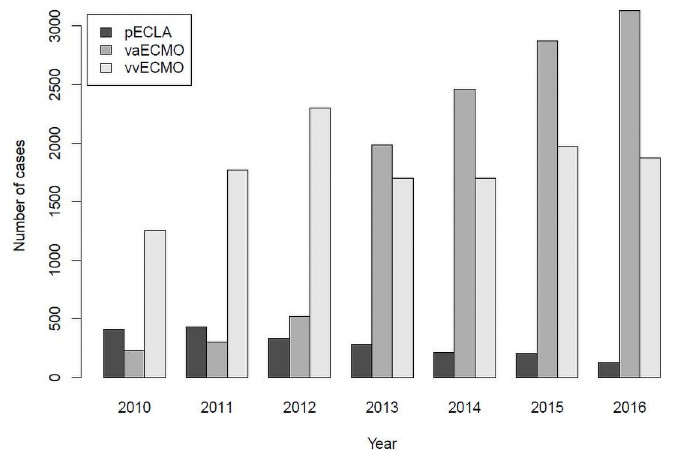
Fig 1. Annual volume of ECMO. Annual volume of ECMO coding in Germany / year.